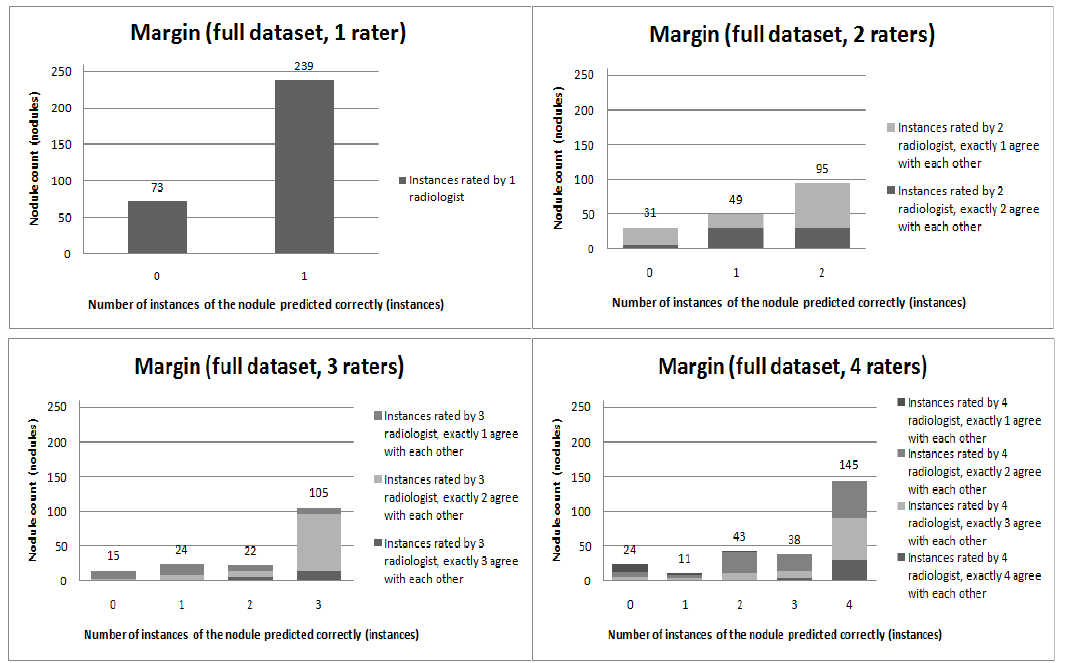
Figure 8. Visual overview of the ensemble of classifiers’ agreement with the panel of experts’ opinions (Margin).